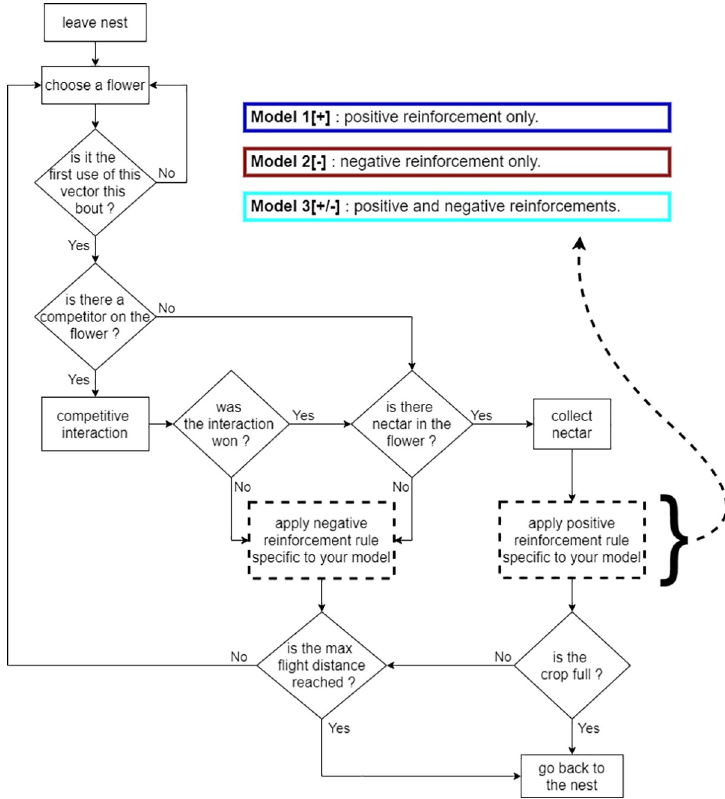
Fig 1. Flowchart summarizing the agent-based models. Rectangles represent actions performed by a bee. Diamonds indicate conditional statements. Arrows connect the different modules. The dashed rectangles are subject to the different rules of the three models.